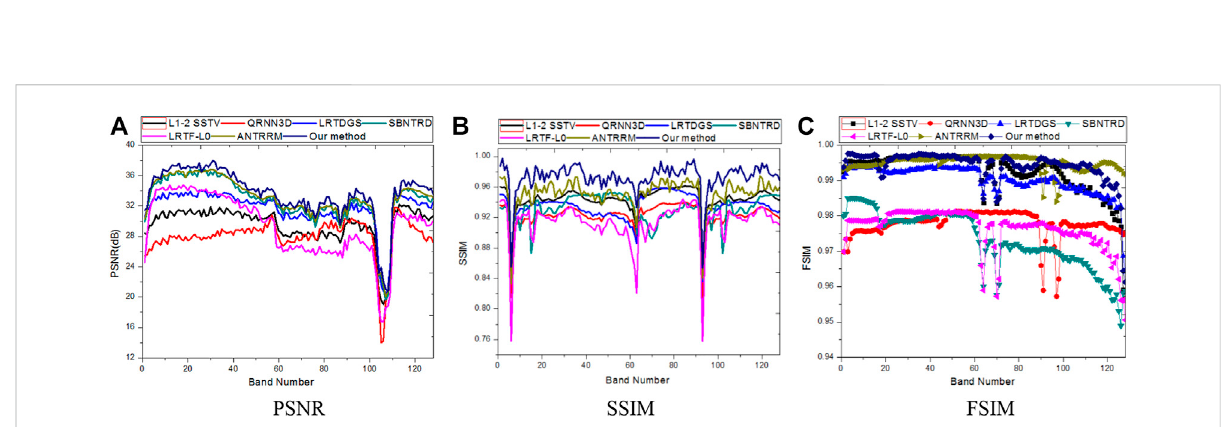
FIGURE 9 The comparative performance of different methods in terms of PSNR, SSIM, and FSIM under Case 4 on INDIAN PINES . (A) PSNR, (B) SSIM, (C) FSIM.